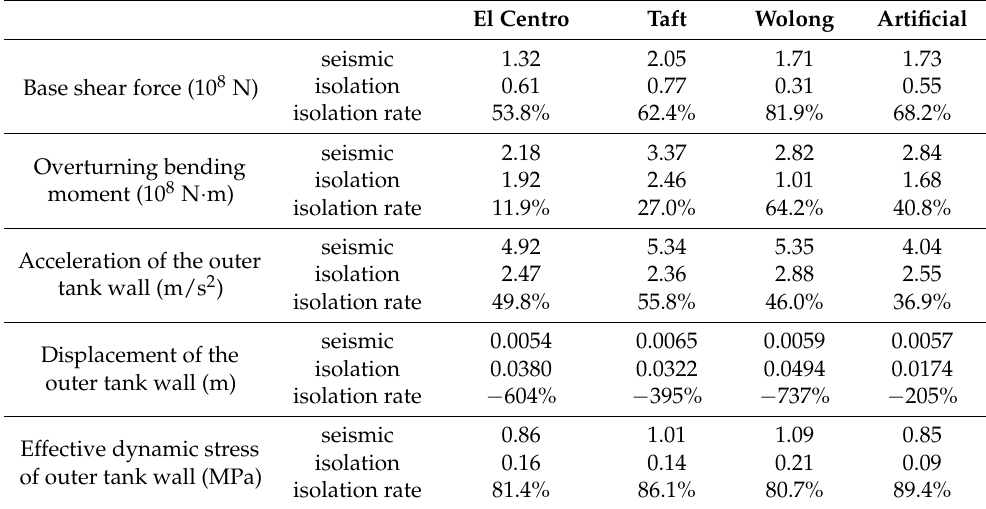
Table 5. Peak seismic response of 200,000 cubic meters of the LNG storage